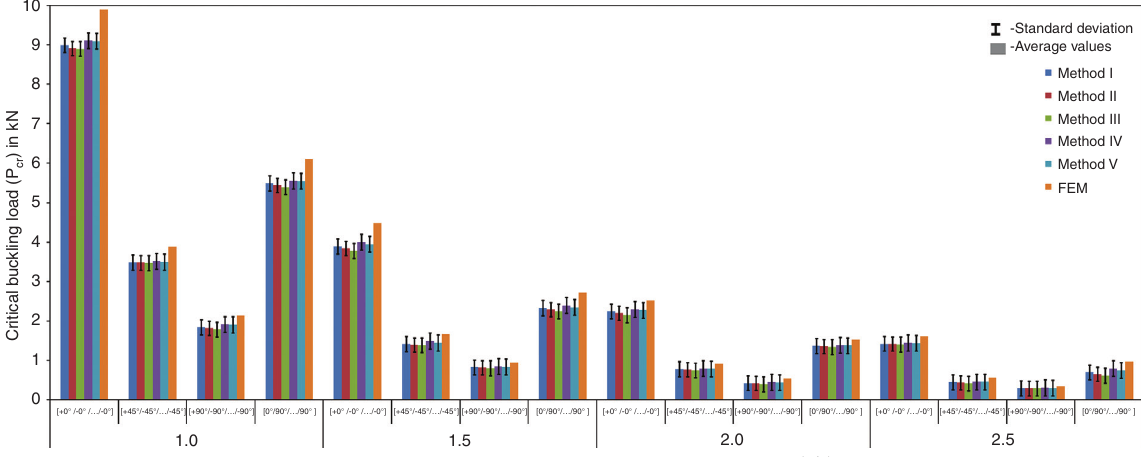
Figure 7 Critical buckling load for laminated skew plate ( α = 0 ° ).